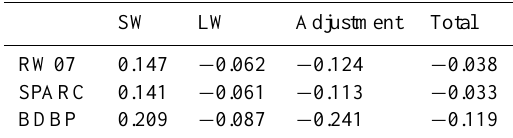
Table 3. The radiative forcing (Wm − 2 ) due to stratospheric ozone changes between 1979–1981 and 1995–1997. The instantaneous shortwave (SW), instantaneous longwave (LW), adjustment due to stratospheric temperature changes, and total radiative forcing are shown.